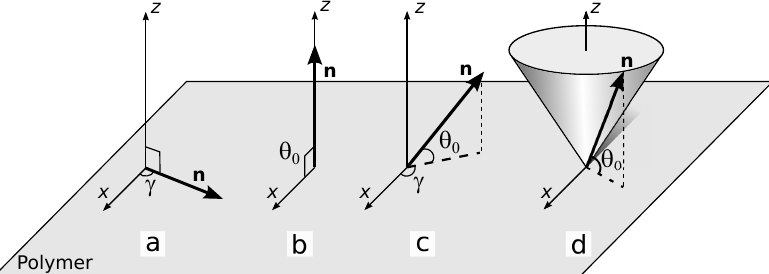
Figure 1. Different types of boundary conditions at the nematic-polymer interface: ( a ) tangential anchoring with specified azimuthal angle γ , ( b ) homeotropic anchoring, ( c ) tilted anchoring with specified azimuthal angle γ and tilt angle θ 0 , ( d ) conical anchoring with specified tilt angle θ 0 and azimuthal